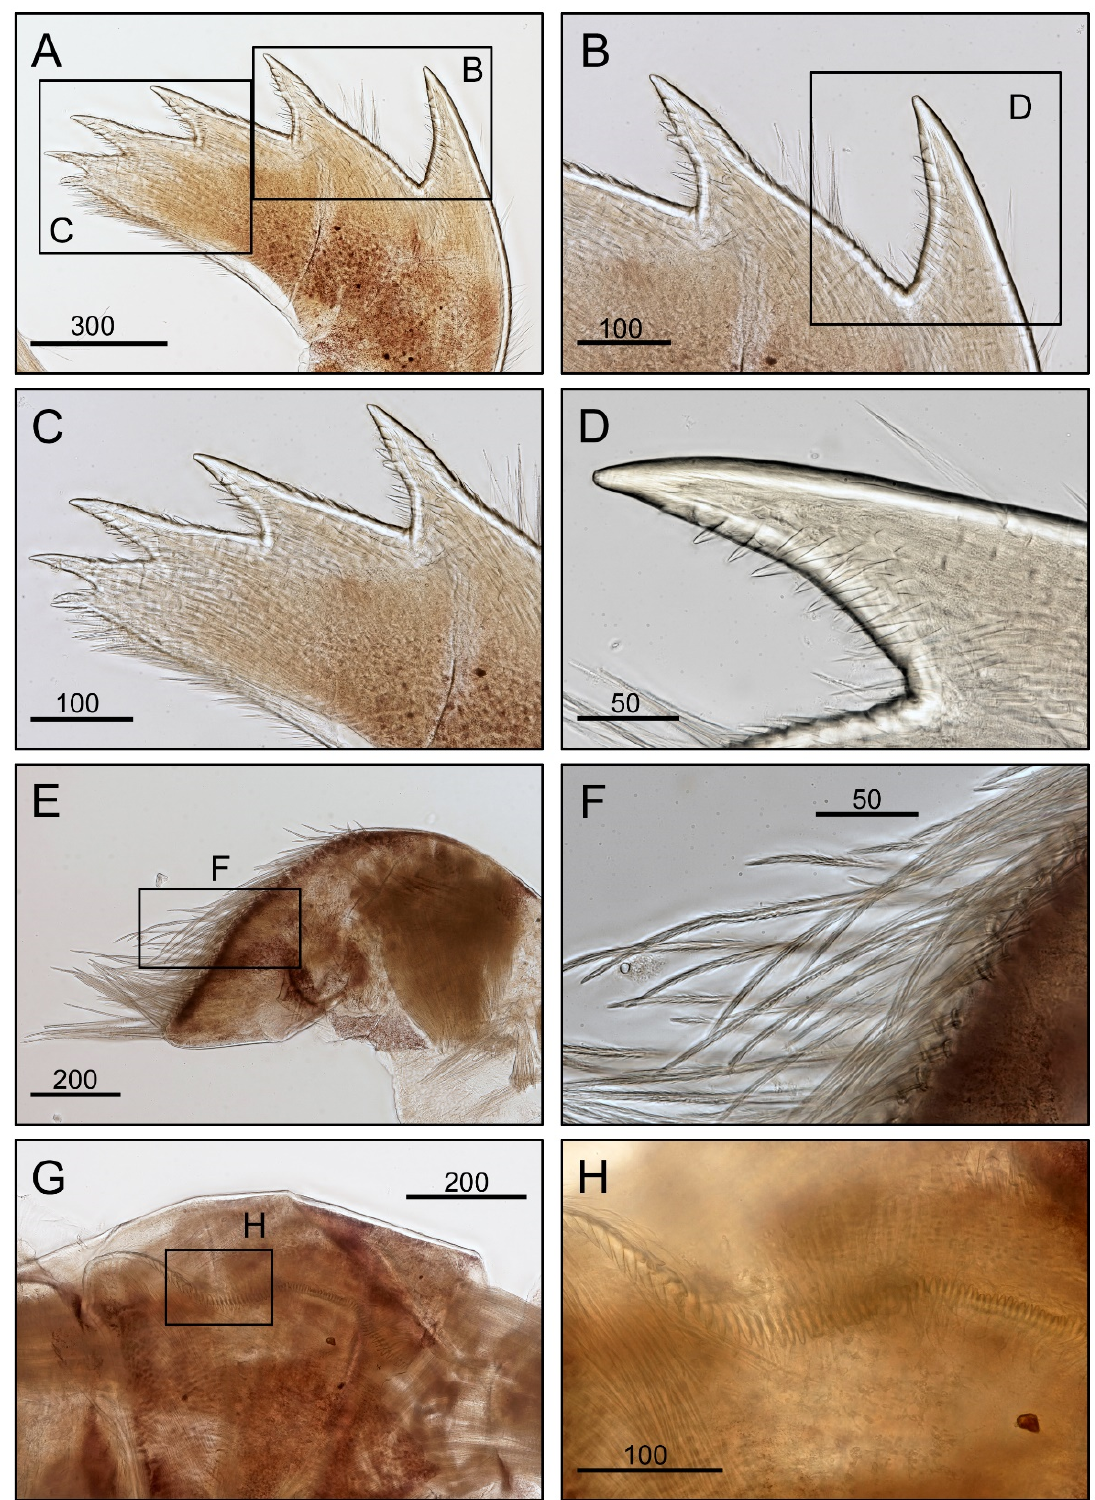
Figure 6. Conchoderma virgatum . ( A ) Mandible showing five teeth. ( B ) First and second teeth of mandible. ( C ) Third, fourth, and fifth teeth of mandible. ( D ) First teeth of mandible showing a surface with dense simple setae. ( E ) Mandibulatry palp. ( F ) Serrulate setae at the margin of palp. ( G ) Labrum. ( H ) Cutting edge of labrum showing small teeth. Scale bars in μ m. Distribution: Cosmopolitan. On surfaces of buoys, snakes, sea turtles, copepods, isopods, fishes.